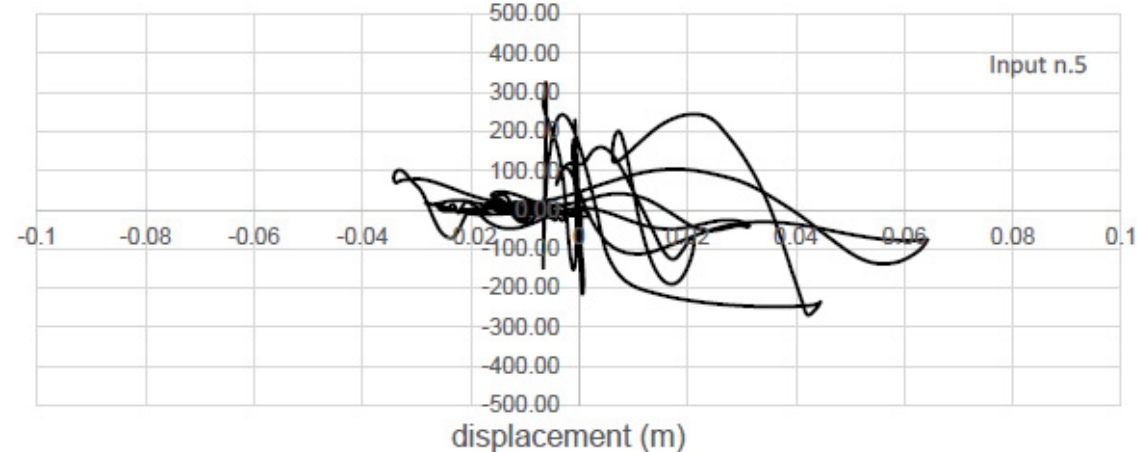
Figure 12. Displacement vs. Base Shear (Input motion: RRS). Table 9. Lognormal values.